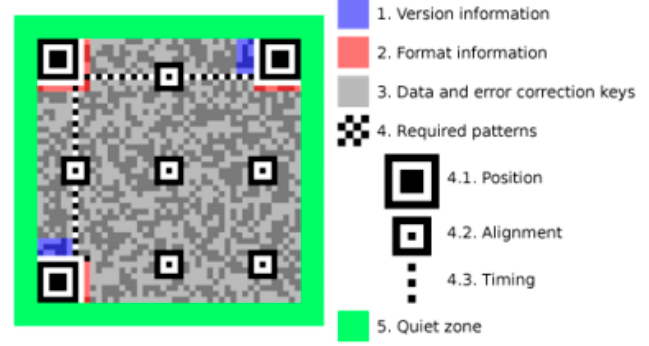
Figure 2. QR code (version 7) structure [23].